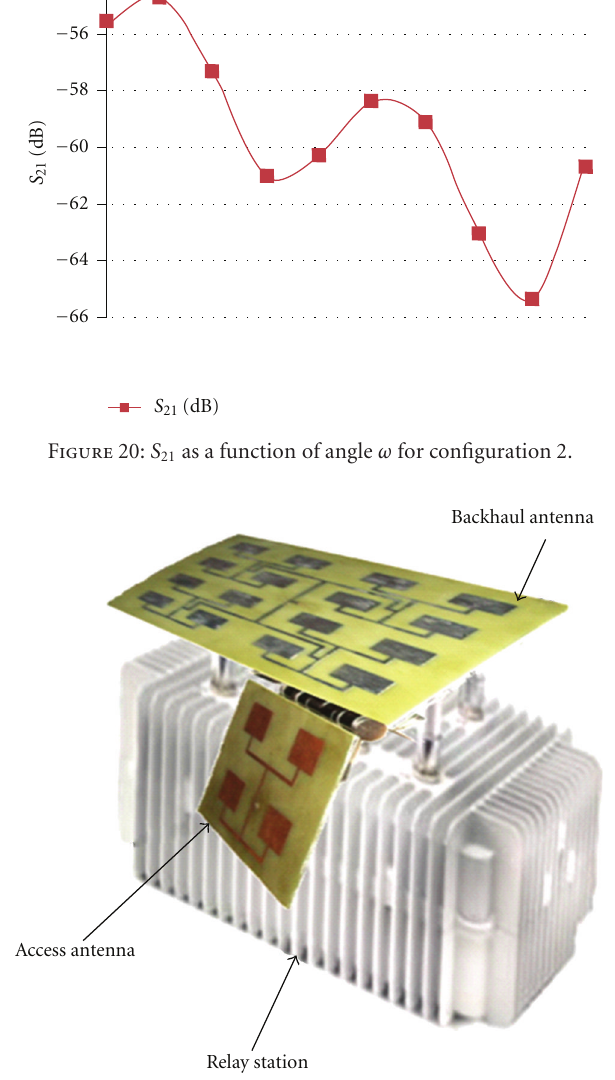
Figure 21: Relay station with the proposed antennas.